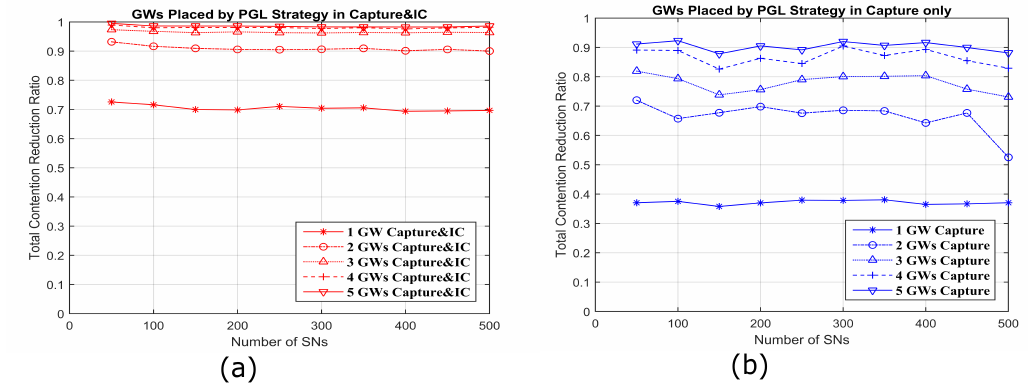
Figure 15. The results with GWs placed by the PGL algorithm with capture and IC and capture only both show that a given number of GWs can give a predictable contentions reduction even with more SNs. However, with capture and IC, the reduction of contentions has much more than that with capture